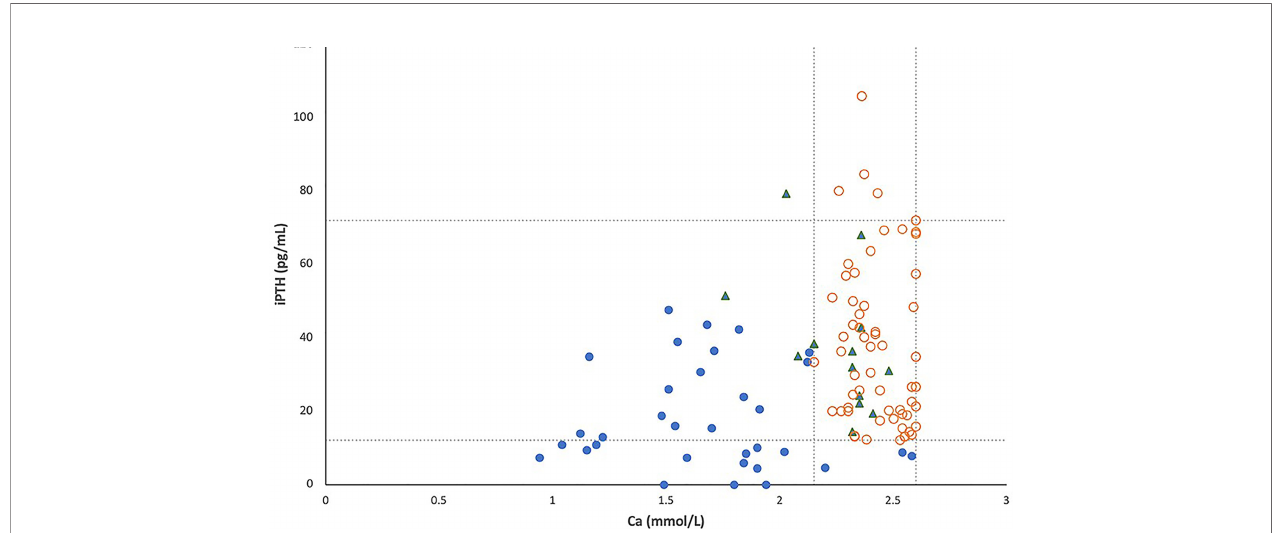
FIGURE 1 | The relationship between serum total calcium and intact PTH levels in 104 patients with 22q11.2 deletion syndrome, including 33 patients with hypoparathyroidism ( ● ), 13 patients with a history of hypocalcemia due to other causes ( ▲ ) and 58 patients with normal parathyroid reserve ( ○ ). Lines represent pediatric normal ranges of total calcium and intact PTH levels.